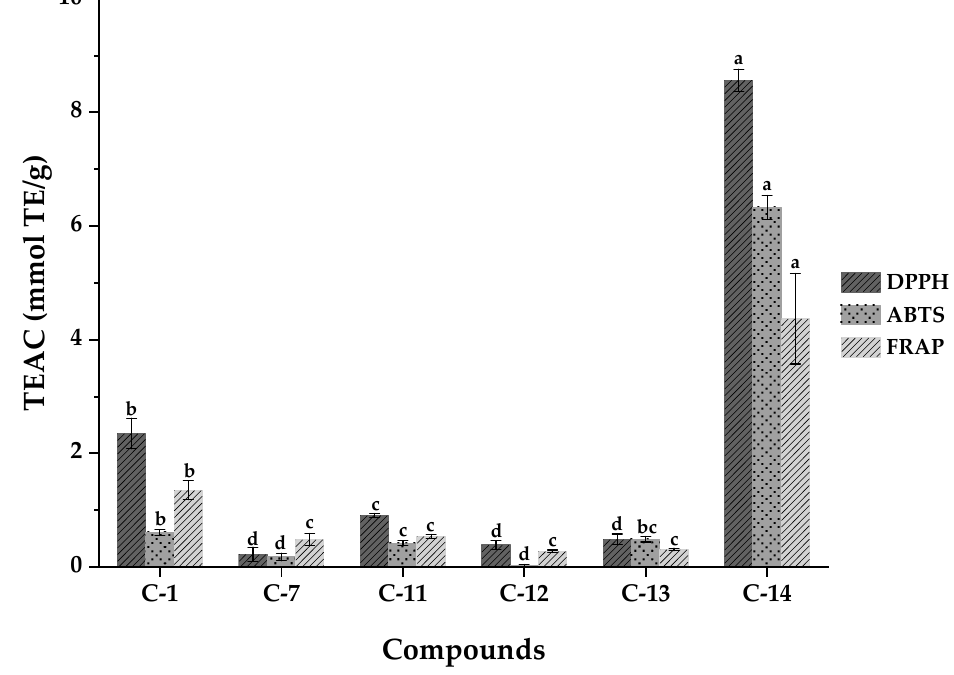
Figure 6. Trolox equivalent antioxidant capacity (TEAC) of compounds isolated from WUE-A4 tested by DPPH, ABTS and FRAP assays. Means labeled by different letters ( a–d ) were significantly different at a level of p < 0.05 (n = 3) by DMRT (Duncan’s multiple range test).